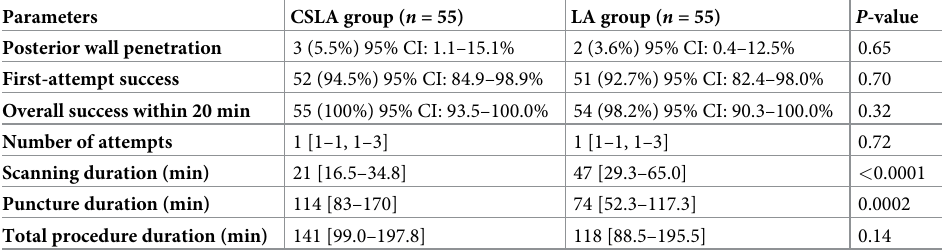
Total procedure duration (min) 141 [99.0–197.8] 118 [88.5–195.5] 0.14 Data are expressed as medians [interquartile ranges, ranges], medians [interquartile ranges], or numbers (proportions). CI, confidence interval; CSLA, combined short-axis out-of-plane and long-axis in-plane approach; LA, long-axis in- plane